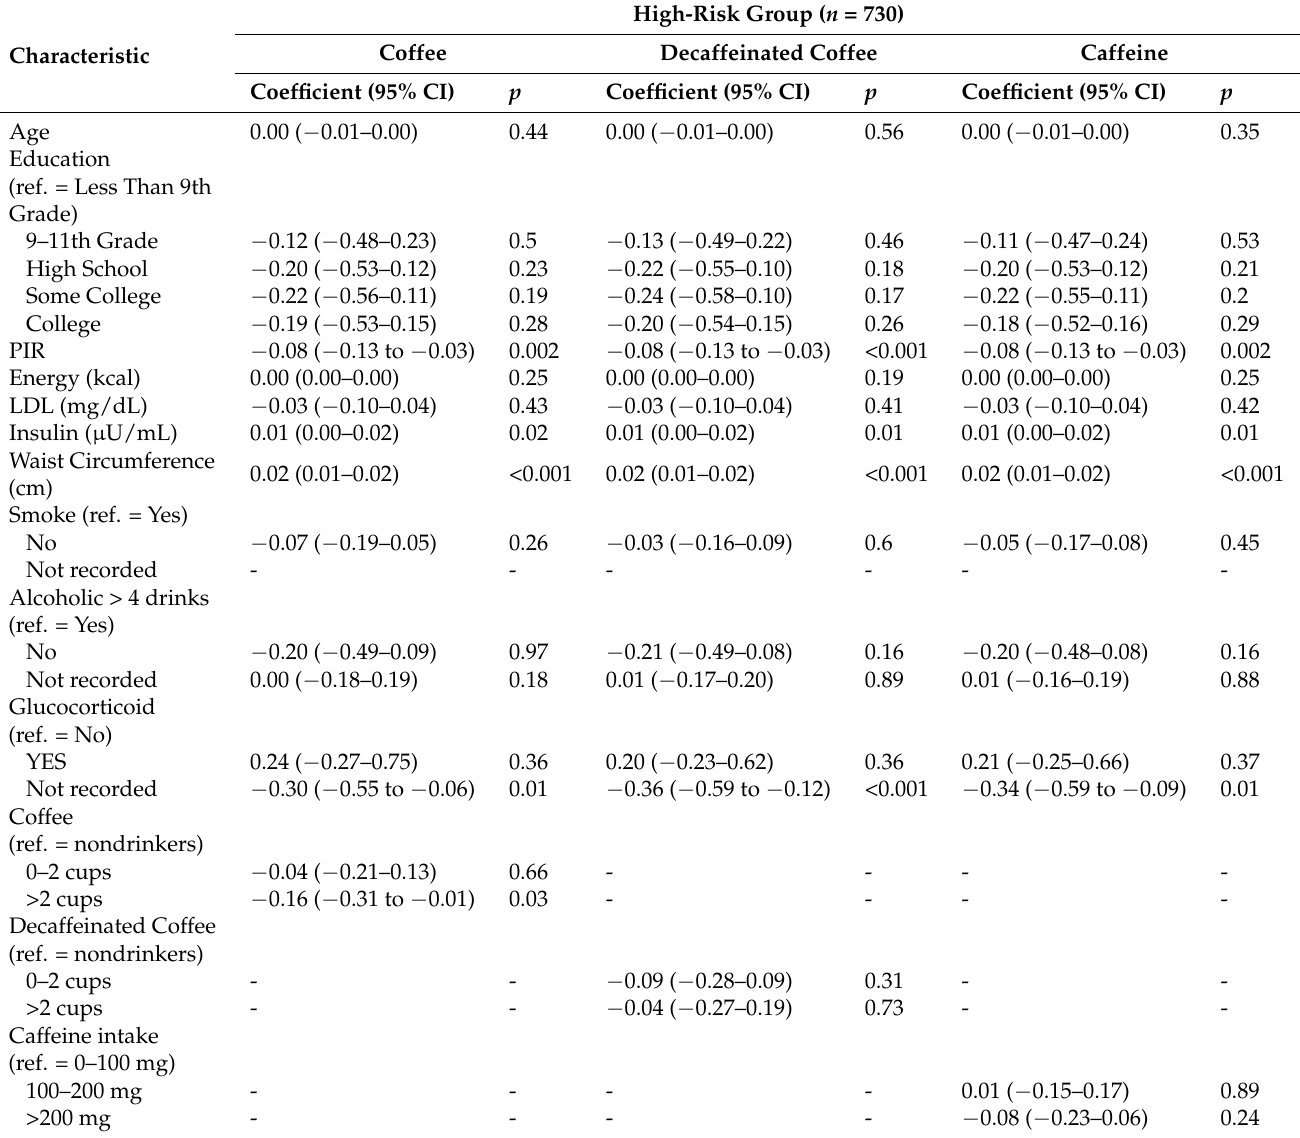
Table 4. Adjusted association between coffee, decaffeinated coffee, and caffeine intake and MetS z-score in high-risk